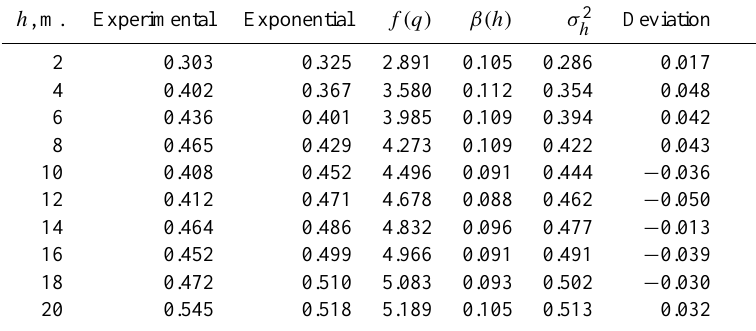
Table 1. Pulacayo Mine variogram model, Experimental values from Matheron (1962, p. 180); Lag distance ( h) in m; Exponential values = β × f (q) is extension variance of 50cm line segments; from model of Fig. 6; f (q) as in Eq. (4); β(h) = Experimental value/ f (q) ; σ 2 h Deviation is difference between colums 2 and 6. The small deviations indicate good fit of Matheron’s variogram model. h , m. Experimental Exponential f (q) β(h) σ 2 Deviation h 2 0.303 0.325 2.891 0.105 0.286 0.402